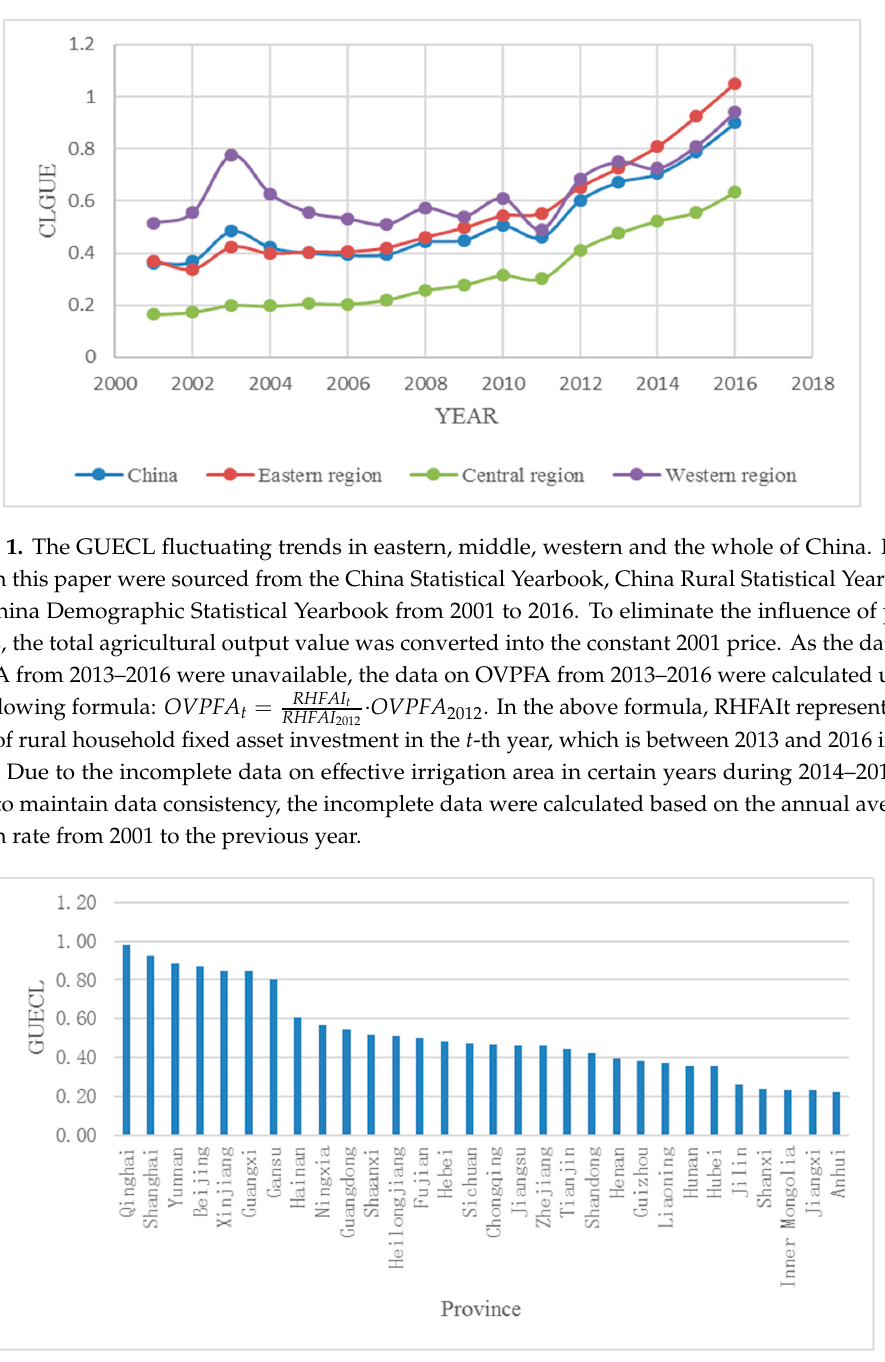
Figure 2. The mean GUECL in 30 provinces in China from 2001–2016. Note: According to the economic development level, this paper classifies China's 31 provinces into three regions: the eastern, central and western regions. The eastern region includes Beijing, Tianjin, Hebei, Liaoning, Shanghai, Jiangsu, Zhejiang, Fujian, Shandong, Guangdong and Hainan. The central region includes Shanxi, Jilin, Heilongjiang, Anhui, Jiangxi, Henan, Hubei, and Hunan. The western region includes Sichuan, Chongqing, Guizhou, Yunnan, Shaanxi, Gansu, Qinghai, Ningxia, Xinjiang, Guangxi, and Inner Mongolia. Due to its special natural and geographical conditions, Tibet is not included in this study. Limited by data, Hong Kong, Taiwan and Macao are not included in this